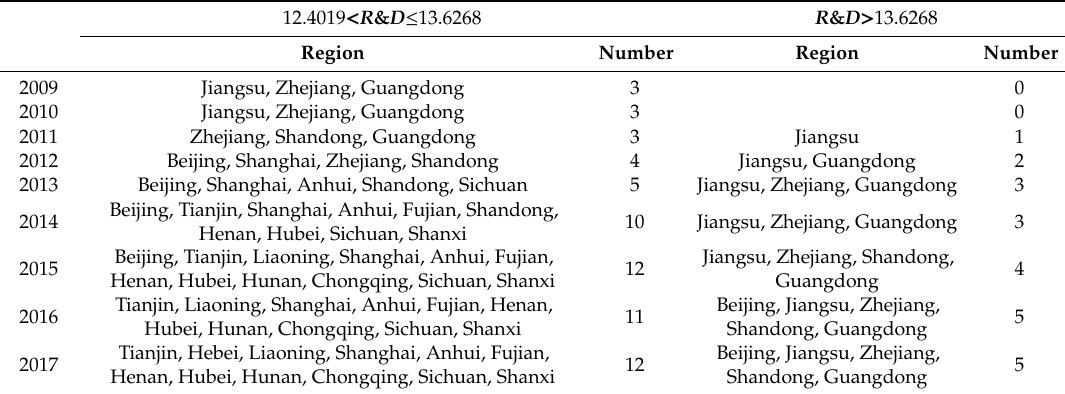
Table 5. Distribution of relative thresholds of technology innovation levels in 30 provinces of China from 2009 to